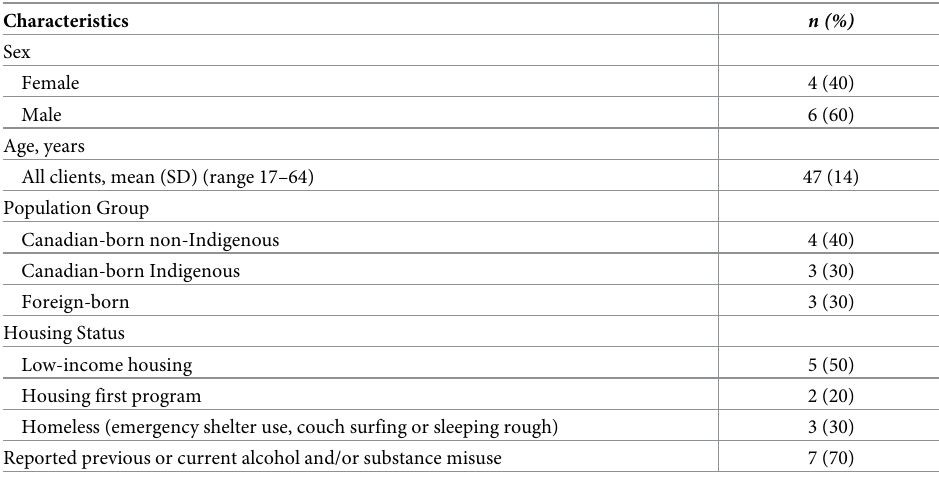
Table 1. Demographic characteristics of clients (n =